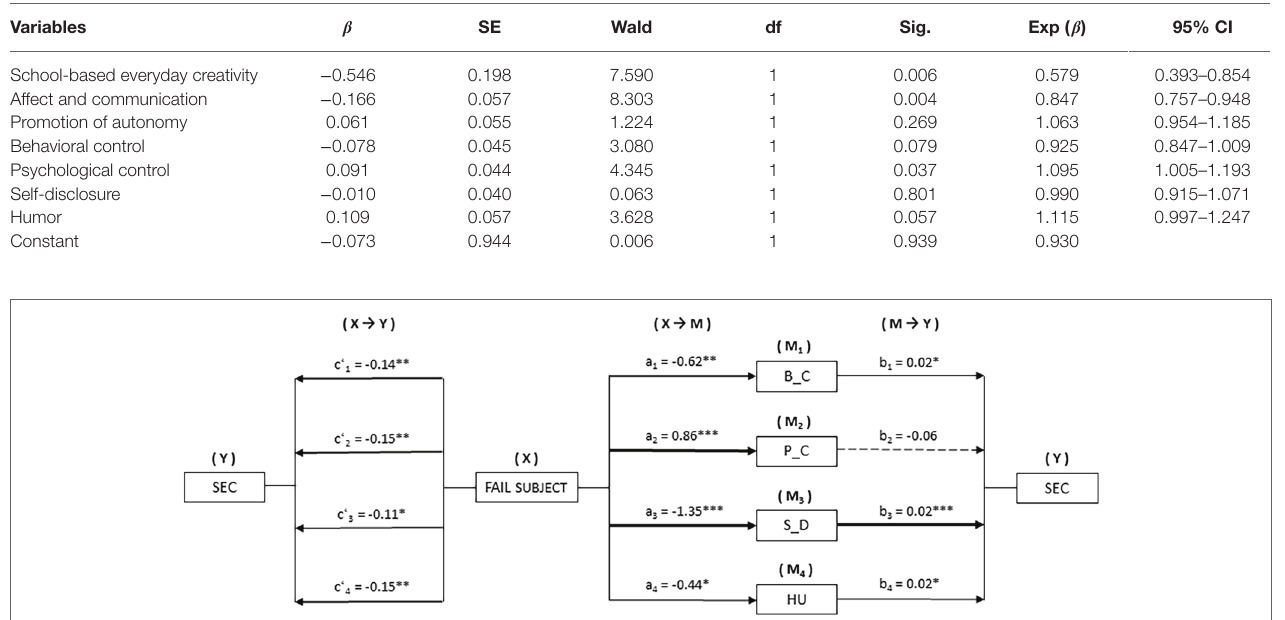
TABLE 4 | Results derived from the logistic regression for the probability of repeat year, according to everyday creativity and parental styles. Variables β SE Wald df Sig. Exp ( β ) 95% CI School-based everyday creativity − 0.546